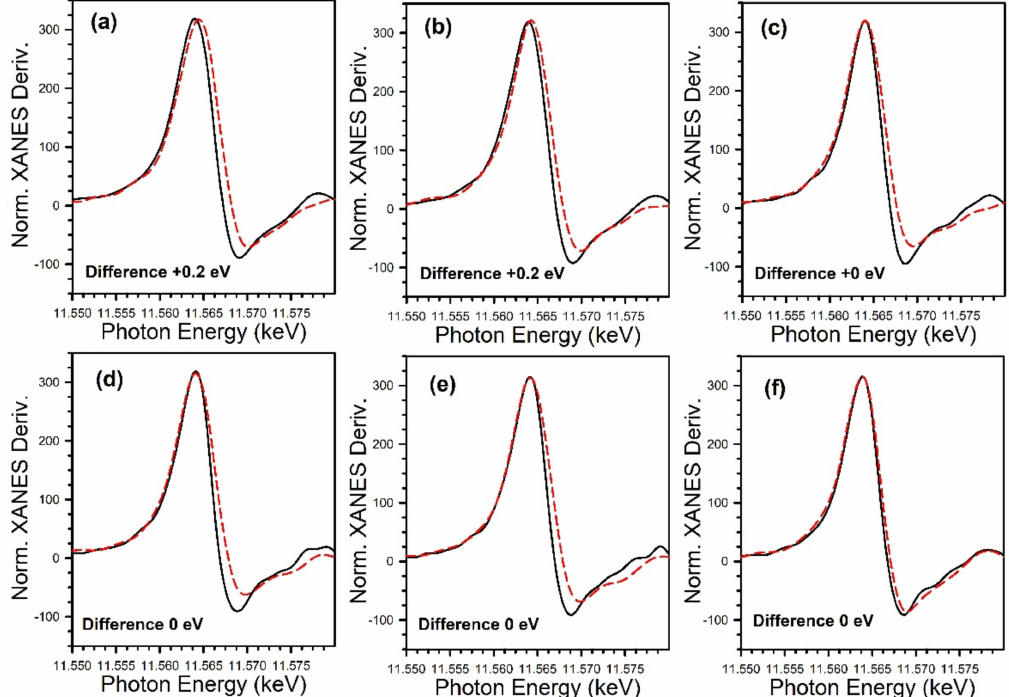
Figure 17. XANES derivative spectra at the Pt L 3 edge of (solid line) the Pt 0 foil and (red line) the catalysts following reduction in pure hydrogen, including 2% Pt/ZrO 2 with: ( a ) 0% Rb, ( b ) 0.93% Rb, ( c ) 1.86% Rb, ( d ) 2.79% Rb, ( e ) 4.65% Rb, and ( f ) 9.3% Rb-2% Pt/ZrO 2 . No evidence for e - transfer to Pt from Rb + was